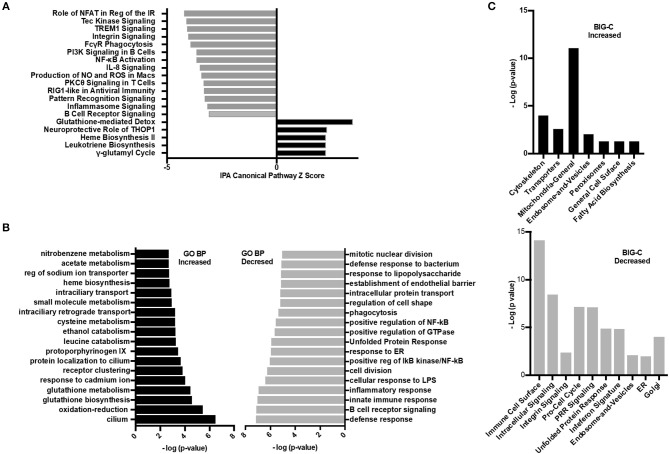
Inhibition of HDAC6 altered transcripts associated with cellular metabolism. (A) Ingenuity pathway analysis (IPA) was performed on the differentially expressed transcripts between HDAC6 inhibitor treated and untreated NZB/NZW mice. The most significant signaling pathways increased or decreased by Z score analysis with an overlap p-value ≤ 0.05 are shown. The full list of significant increased and decreased pathways and the genes used to determine significance are in Supplementary Data 3 (increased) and Supplementary Data 4 (decreased). (B) GO biological pathway enrichment analysis of the top most increased and decreased pathways by lowest overlap p-value significance. A full list of GO biological pathways enriched (p < 0.01) are in Supplementary Data 5 (increased) and Supplementary Data 6 (decreased). (C) BIG-C pathway enrichment was performed using increased (left) or decreased (right) transcripts from the DE analysis of HDAC6 inhibitor treated NZB/NZW mice compared to NZB/NZW mice. The -log (p-value) is shown for the enriched categories. Gene symbols corresponding to each category are listed in Supplementary Data 7 (increased) and Supplementary Data 8 (decreased).